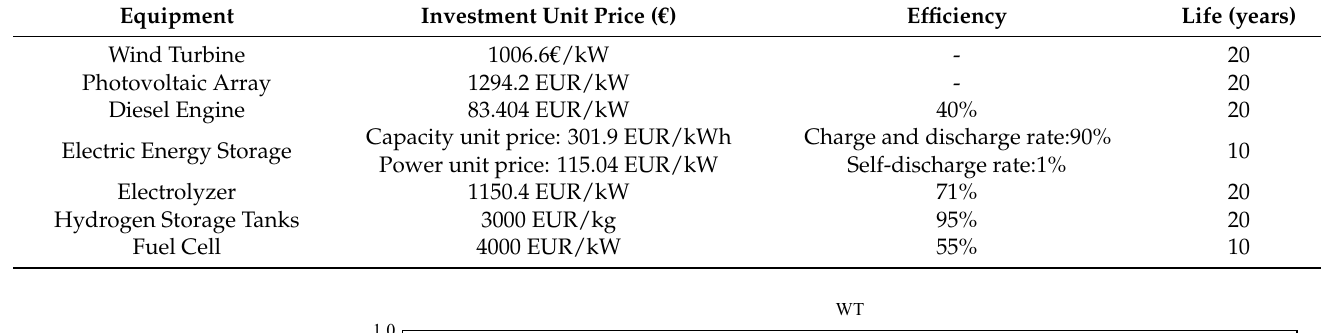
Table 6. Investment Parameters of Microgrid Equipment.